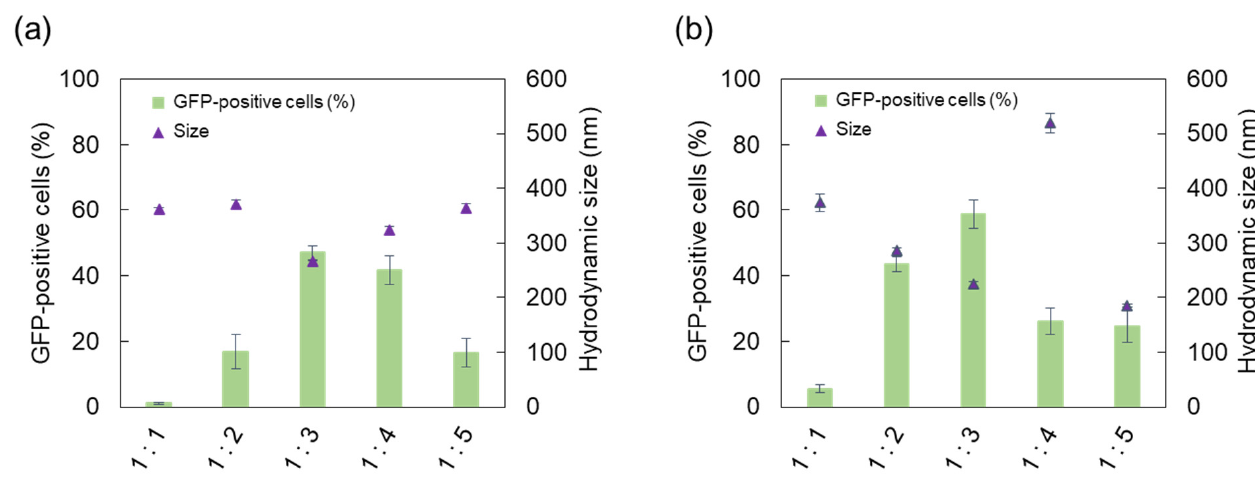
Figure 1. Transfection efficiency and hydrodynamic size of lipoplexes formed under different conditions of the constituent ratio: ( a ) the molar ratio of DC-Chol to DOPE; ( b ) the charge ratio of pDNA to DC-Chol. Analysis was conducted at 24 h post-transfection. Opti-MEM (Gibco) was used as the complexation solution. Among the transfected cells, GFP-positive cells were determined. The results represent the mean ± standard deviation ( n = 3). GFP, green fluorescent protein; DC-Chol, 3 β -[N-(N (cid:48) ,N (cid:48) -dimethylaminoethane)-carbamoyl]cholesterol hydrochloride; DOPE, 1,2-dioleoyl- sn -glycero-3- phosphoethanolamine; pDNA, plasmid